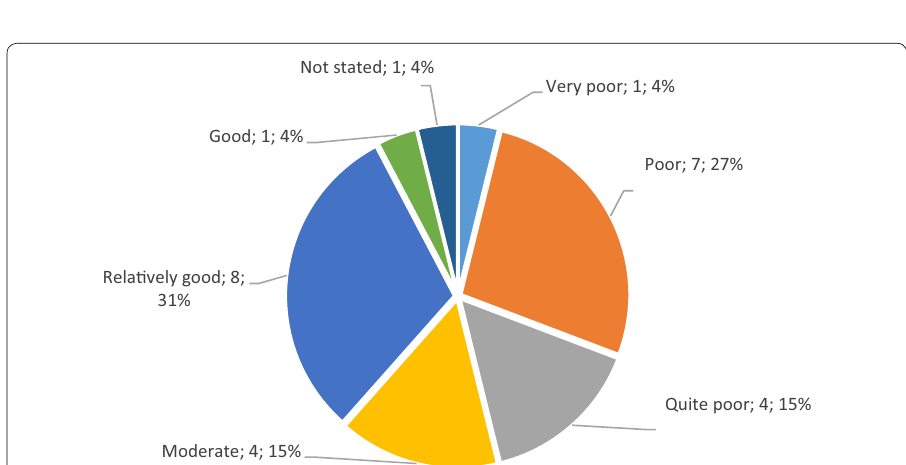
Fig. 3 Participants by status of information on OA (self‑assessment), n